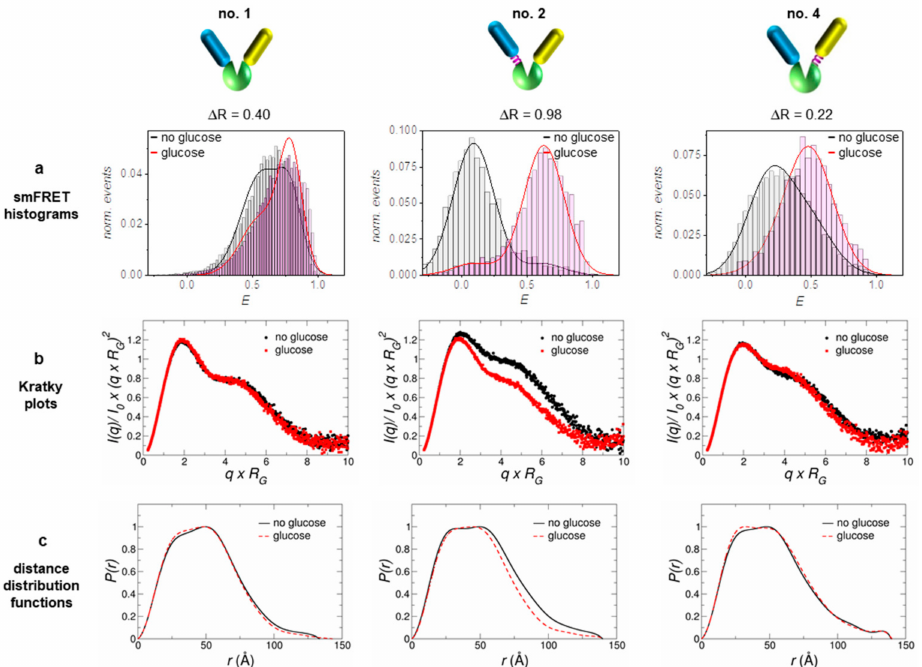
Figure 1. The three investigated sensor constructs exhibit structural differences with respect to how the FPs are attached to the glucose binding protein MglB: no linker between MglB and both FPs (no. 1, left), a flexible linker between MglB and the donor FP (no. 2, middle) and a flexible linker between MglB and the acceptor FP (no. 4, right). The corresponding ∆ R-values were determined from ensemble Förster resonance energy transfer (FRET) measurements (FRET binding isotherms, see [18]). ( a ) Data from single molecule measurements (smFRET histograms) were taken from an earlier publication, where these constructs were analyzed in detail [18]. Based on the analysis of the measured small angle X-ray scattering (SAXS) data, the respective Kratky plots ( b ) and distance distribution functions ( c ) are presented in the two lower lines. For further details, refer to the Supplementary Materials, Figures S3.2 and S3.3, and Table